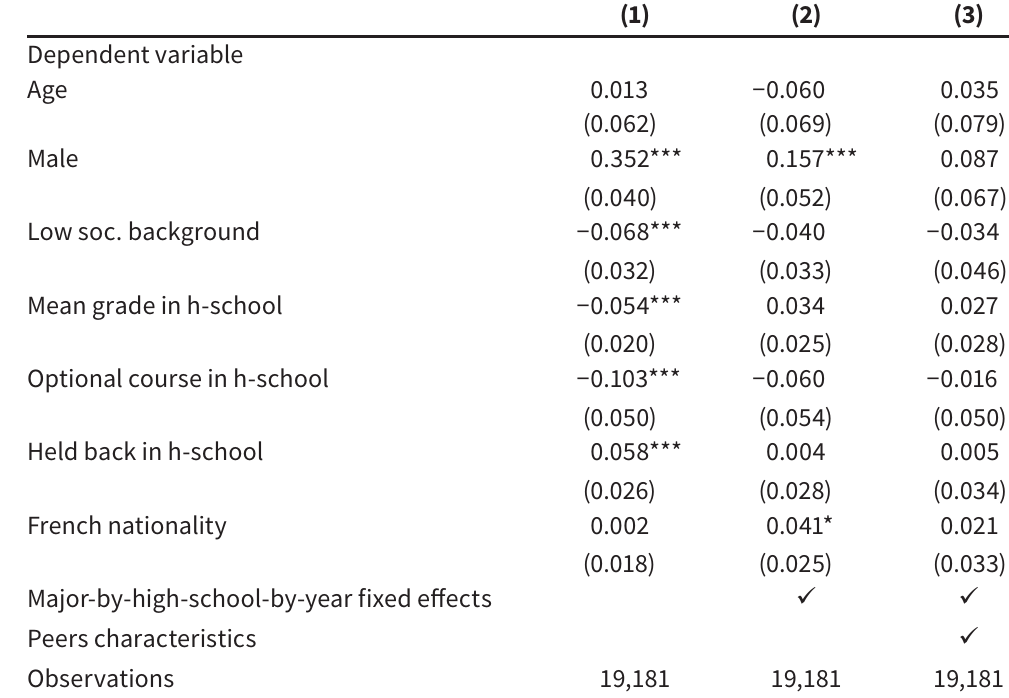
Balancing tests for the proportion of peers with C